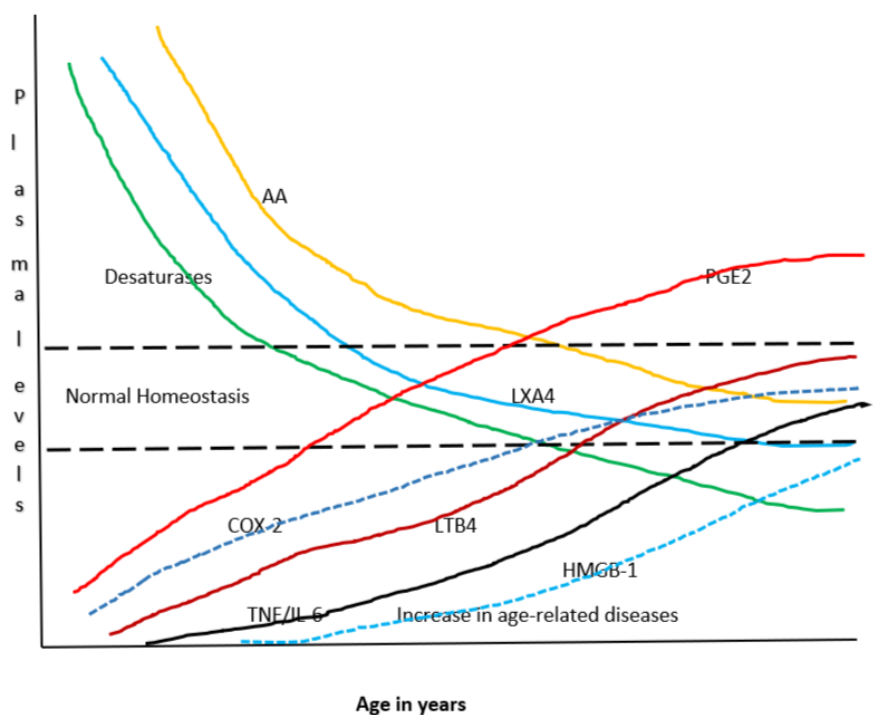
Figure 6. Scheme showing potential relationship among AA, PGE2, LXA4, desaturases and cytokines with age. It can be seen that with advancing age there is a gradual decrease in the activity of desaturases and a steady fall in the concentra- tions of AA and LXA4 and a gradual increase in that of PGE2, LTB4 and TNF-α and IL-6. Thus, with advancing age there is gradual and steady increase in pro-inflammatory status and an increase in age-related diseases and a decline in the ability of tissues/cells/organs/humans to fight or ameliorate inflammation due to a decline in anti-inflammatory mole- cules/capacity. It is envisaged that under normal physiological conditions a delicate balance is maintained among all these molecules/enzymes to maintain homeostasis.